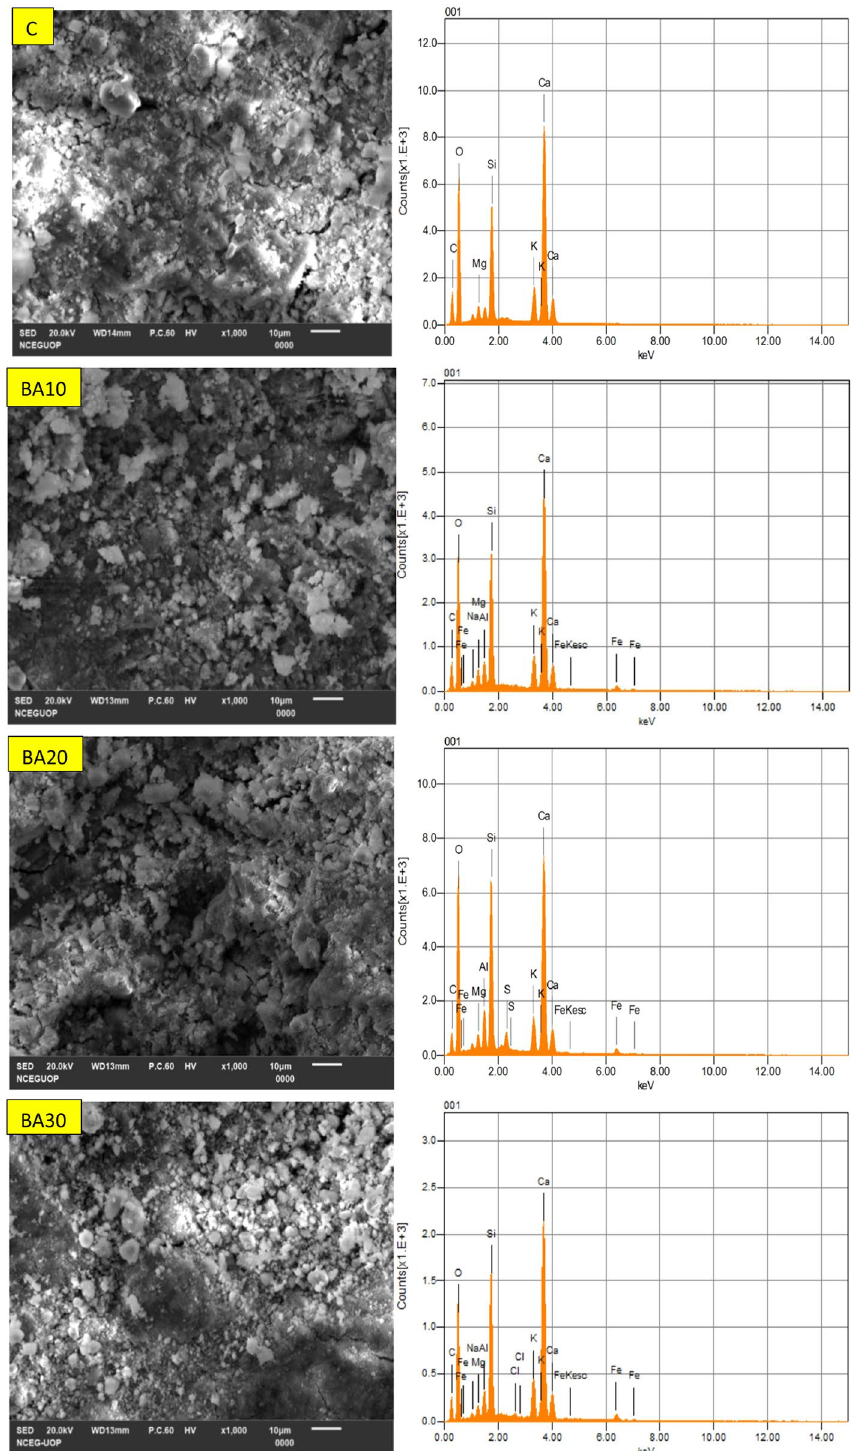
Figure 10. SEM–EDS spectrum of control and paste samples of binary (OPC-BA) and ternary mixes (OPC-